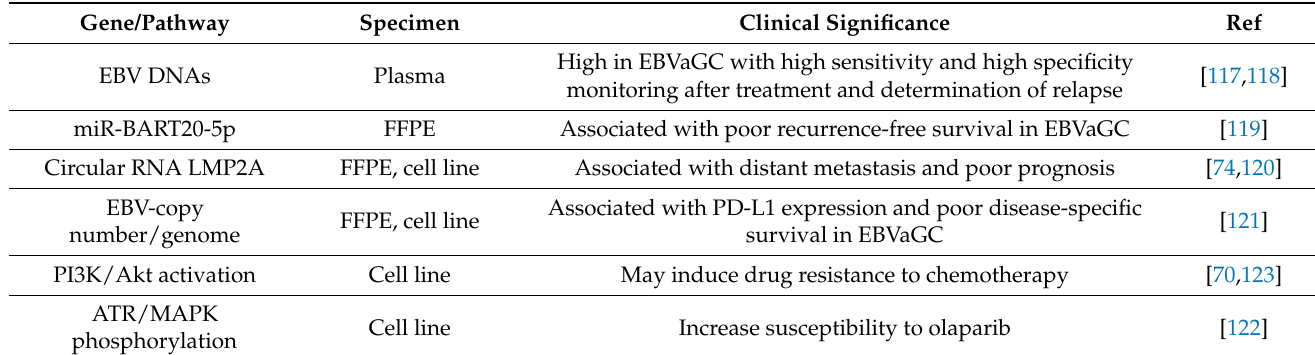
Table 2. Potential diagnostic and prognostic biomarkers of